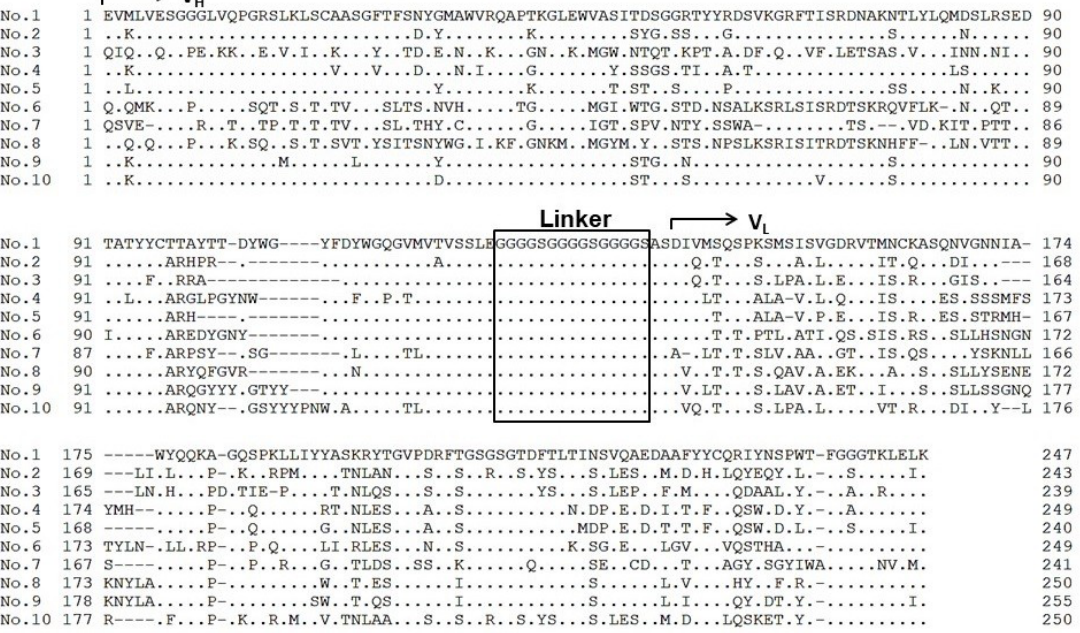
Figure 5. Amino acid sequence alignments of selected clones assayed. V L , V H , and linker sequences are shown. Dots and dashes indicate identical amino acids and deletions, respectively.